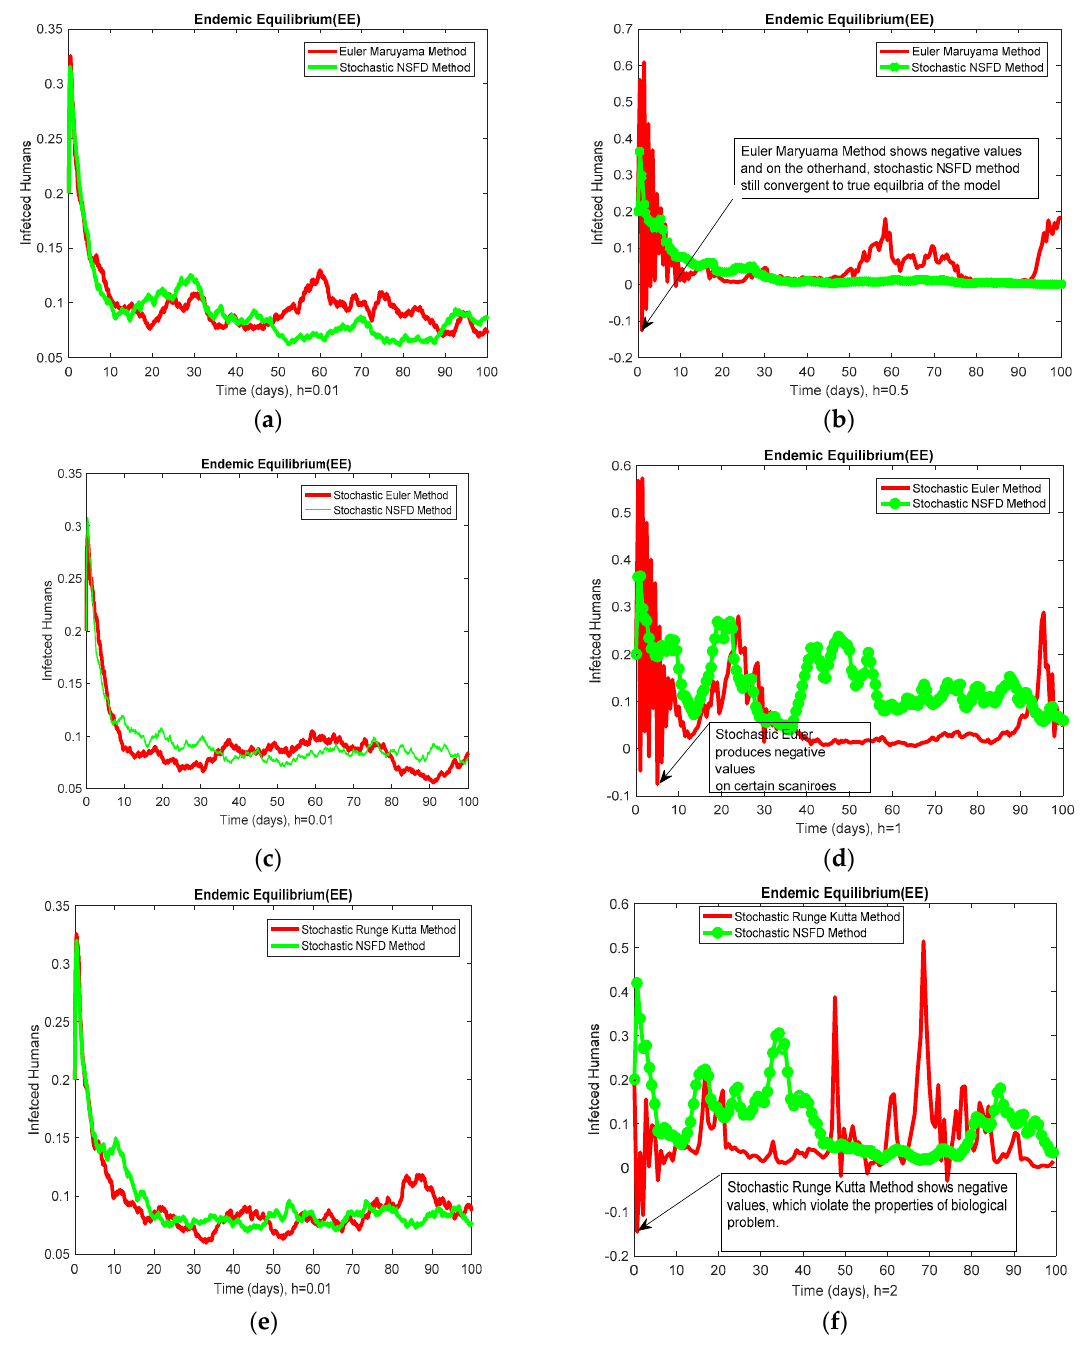
Figure 3. Combined graphical behaviors of NSFD with Euler-Maruyama, stochastic Euler, and stochastic Runge-Kutta methods at different time-step sizes. ( a ) The behavior of infected humans through both methods converge to the proper equilibrium at h = 0.01. ( b ) Euler-Maruyama method diverges and even produces negative values after taking the long-term behavior, but the proposed method is still convergent. ( c ) The stochastic Euler method depicts the exact behavior of the disease,